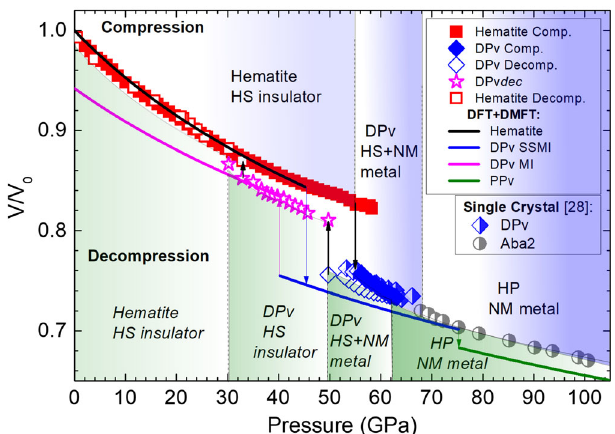
FIG. 1. Pressure dependence of the unit-cell volume of Fe 2 O 3 at room temperature [ V 0 is the unit-cell volume of the hematite phase at 1 bar and 300 K (for details, see Table S-III [46]); lattice volume is normalized to 2 formula units of Fe 2 O 3 , and volume error bars are within the symbol sizes]. Solid and open symbols indicate compression and decompression (powder), respectively, and half-filled symbols correspond to the single-crystal com- pression experiments (DPv and Aba2 structures) [28]. Results of first-principles (DFT þ DMFT) calculations for the hematite, double-perovskite (DPv) and postperovskite (PPv, CaIrO 3 struc- ture) phases are shown by solid lines. Additional abbreviations are defined as follows: double-perovskite phase formed on decompression (DPv ), high-pressure phase (HP), high-spin dec (HS), Mott insulator (MI), nonmagnetic